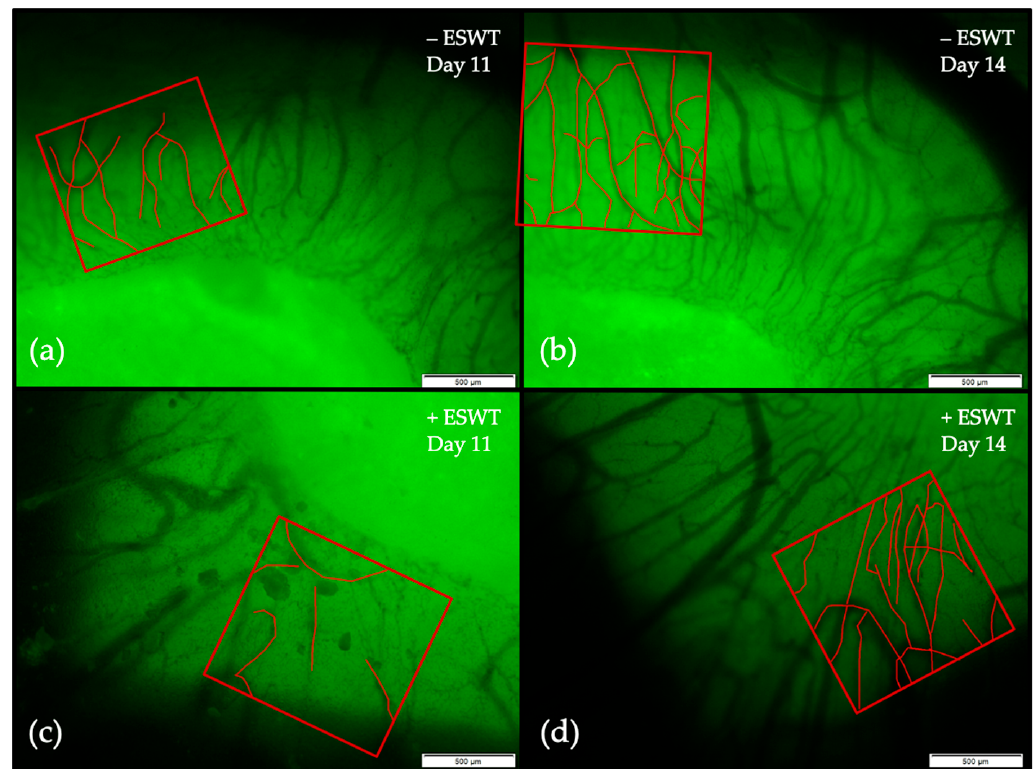
Figure 3. Exemplary pictures of the vessel density analysis. Due to autofluorescence, the brighter structure of the CM was well distinguishable from the surrounding soft tissue. In both groups, the vessel density increased between EDD-11 and EDD-14. ( a ) At EDD-11, the control group showed small and medium sized vessels growing into the transplant. ( b ) Three days later, the density of the vascular network was higher, vessels showed a larger diameter, and the area covered by the tissue was greater. ( c ) Twenty-four hours after ESWT, the vascular network was comparable to the one observed in the untreated specimen. ( d ) Within three days, the vessel density had significantly increased with more vessels of greater diameter growing into the CM compared to the control group. Note, the pictures of the vessel density analysis were further proceeded for vessel junction analysis according to description in the materials and methods section. The scale bar corresponds to a length of 500 µm.